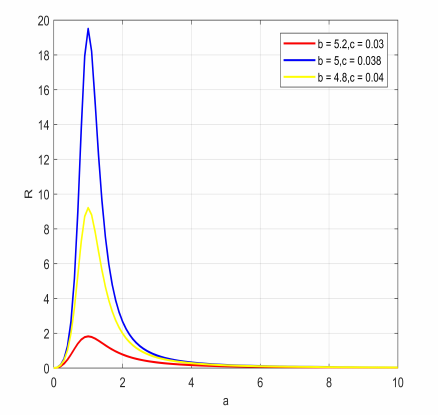
Figure 4. R curve with parameter a .